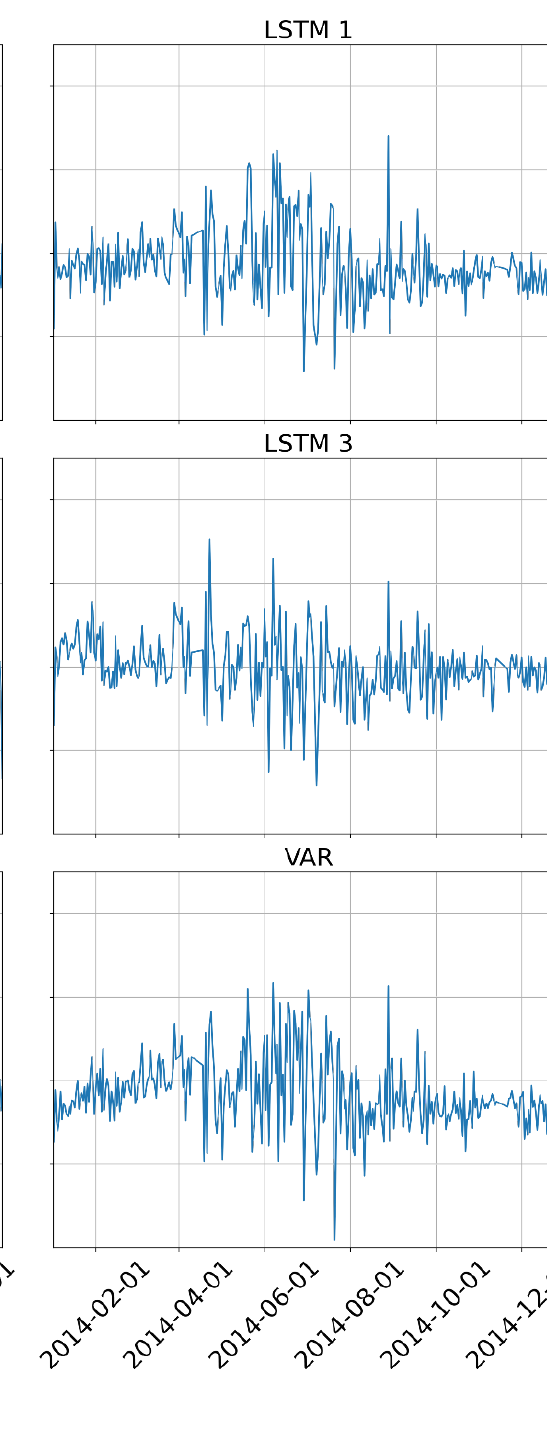
Figure 9. Differences in end-of-day container levels between pump operation optimization using predicted water consump- tion and simulating the optimized pump operation plan with the realized water consumption. The outliers given in Table 2 are